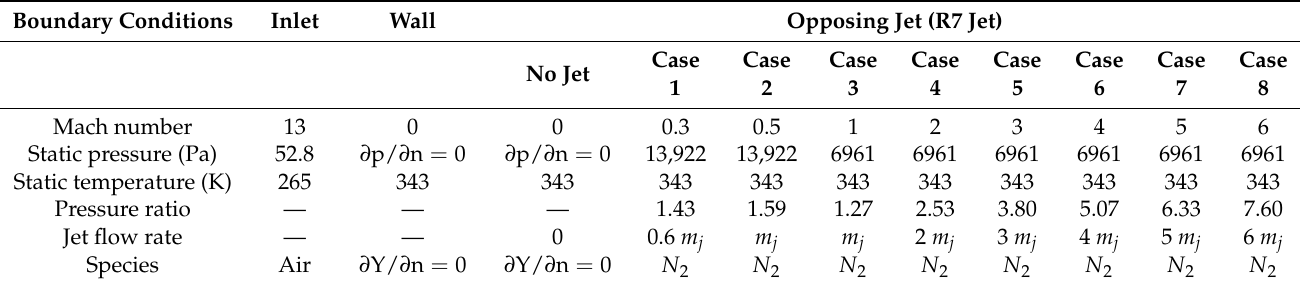
Table 2. Boundary conditions.